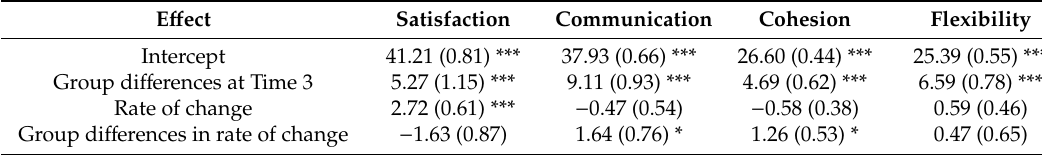
Table 3. Multilevel Growth Curve Modeling Results for Family Dynamics